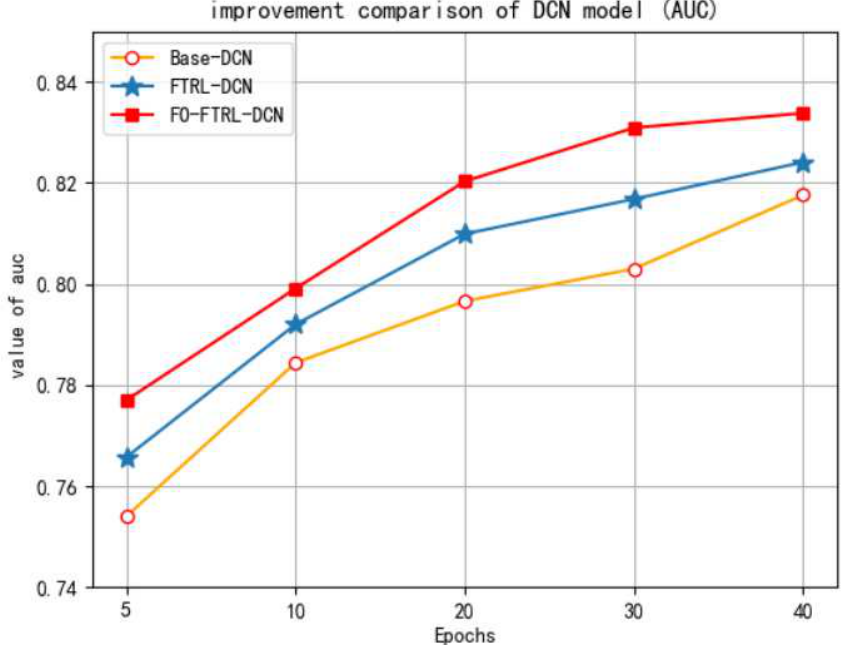
Figure 5. The comparison of DCN model (Area Under the Curve (AUC).